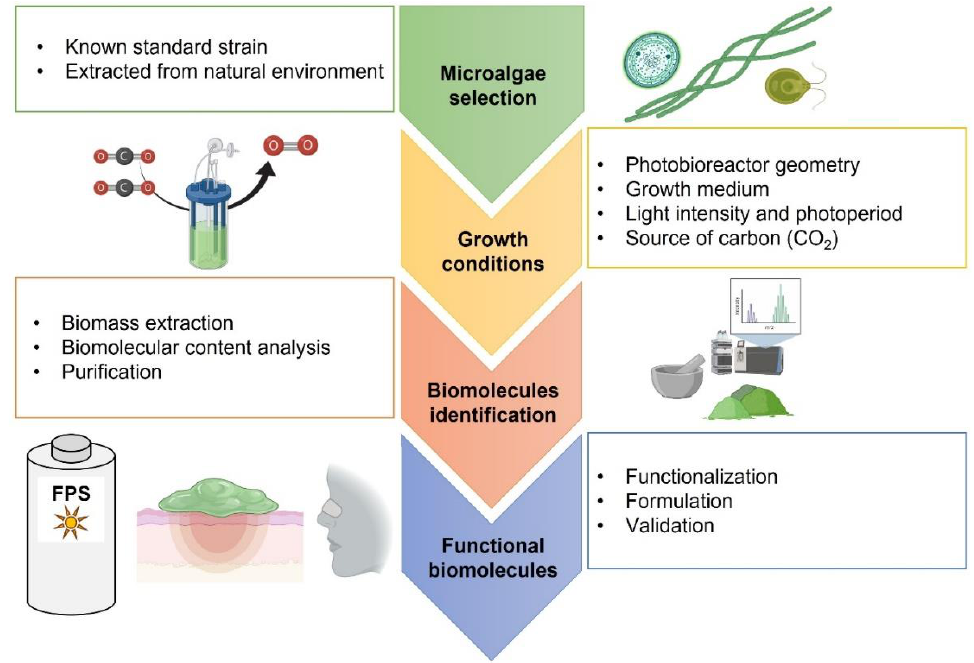
Figure 2. Microalgae-derived biomolecule production. Four main steps are required to obtain biomolecules from microalgae biomass: (1) microalgae selection, (2) culture standardization, (3) purification, and (4) functionalization. Considerations must be made for maintaining sustainability and efficacy. Created with BioRender.com.